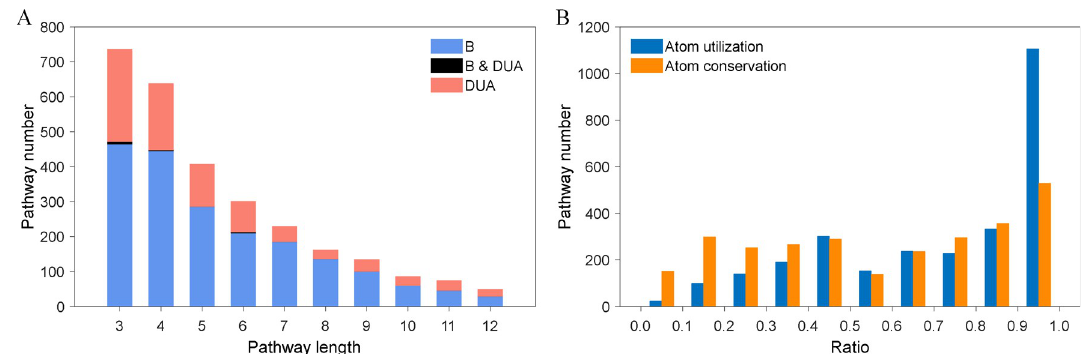
Fig 2. The statistical information of the validation dataset on metabolic pathway. (A) The length distribution of metabolic pathways. B represents the superclass of Biosynthesis, and DUA denotes the superclass of Degradation/Utilization/Assimilation. (B) The utilization distribution of non-hydrogen and critical atoms of the initial substrates (blue columns), and the conservation distribution of non-hydrogen and critical atoms of the target products (orange columns).